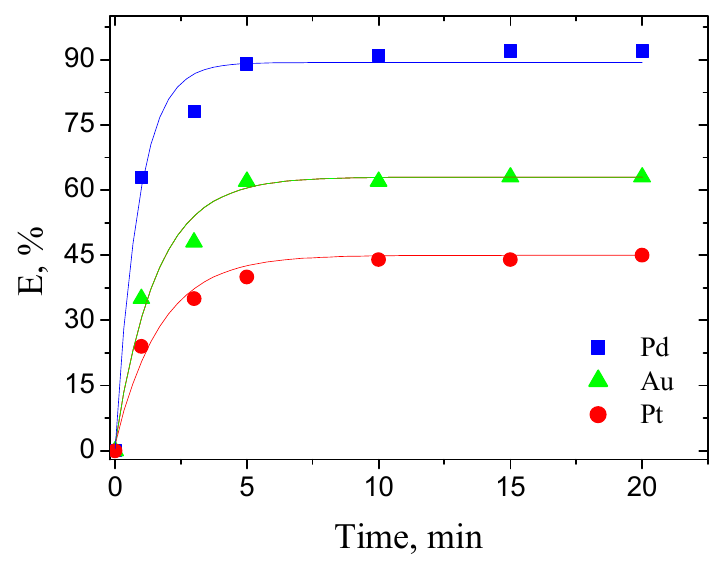
Figure 3. Effect of contact time on extraction of Pd(II), Au(III) and Pt(IV) ions with EDAB-acac in methylene chloride. The initial concentration of each metal ion is 1 mM.